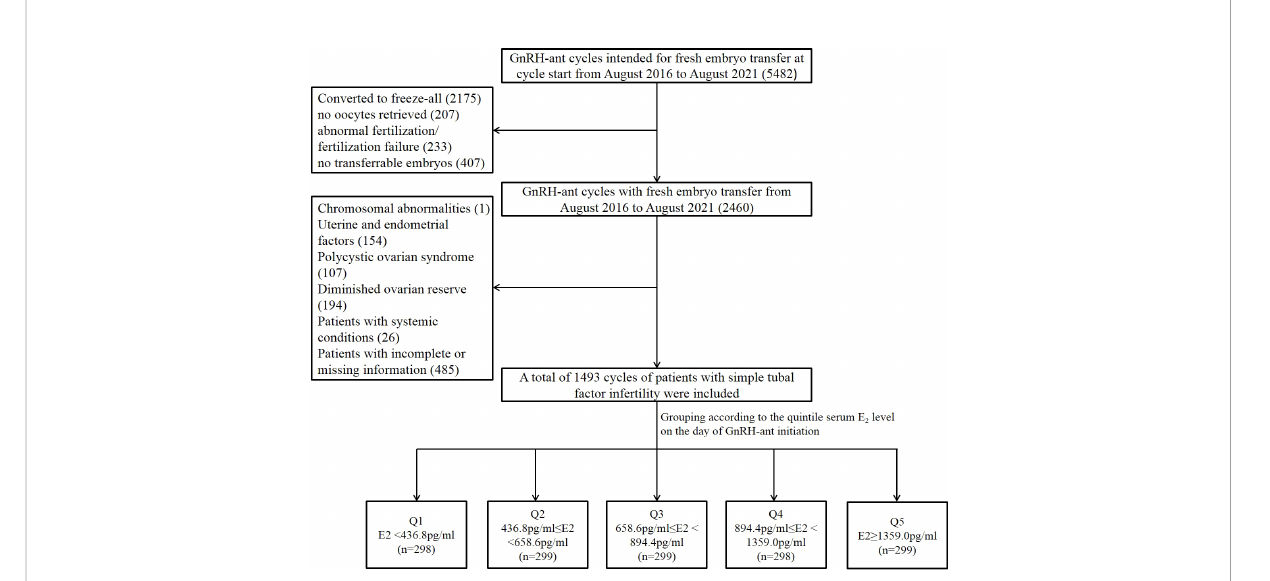
FIGURE 1 Flow chart of the study population selection and grouping. GnRH-ant, gonadotropin releasing hormone antagonist; E2, estradiol; Q1, quintile 1; Q2, quintile 2; Q3, quintile 3; Q4, quintile 4; Q5, quintile